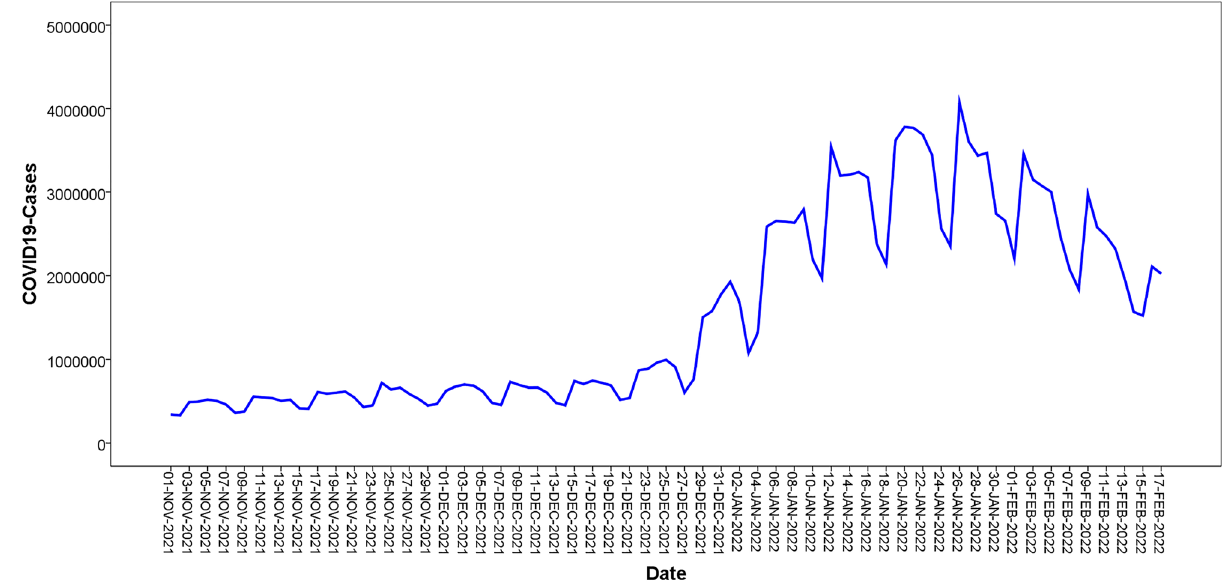
Figure.2. The original sequence chart of the daily confirmed cases of COVID-19 time series.